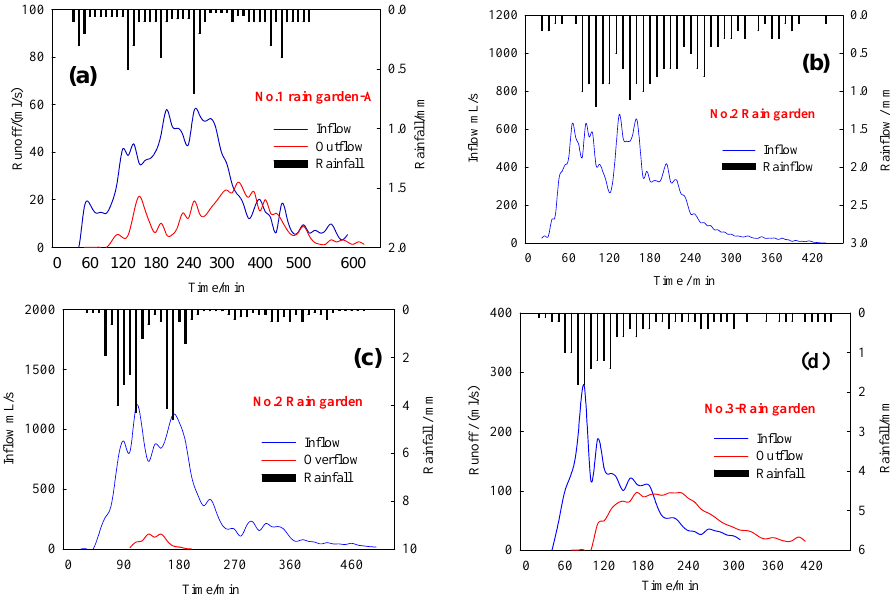
Figure 6. Typical rainfall–runoff processes. Note: Inflow refers to the volume of runoff from road or roof flows into rain gardens; Outflow refers to the volume of runoff discharges from the rain gardens; Overflow refers to the volume of runoff failed to permeate overflows into municipal pipe. ( a ) Runoff processes in rain garden No. 1A on 28 August 2017; ( b ) Runoff processes in rain garden No. 2 on 22 May 2017; ( c ) Overflow processes in rain garden No. 3 on 7 August 2017; ( d ) Runoff processes in rain garden No. 3 on 9 September 2017.